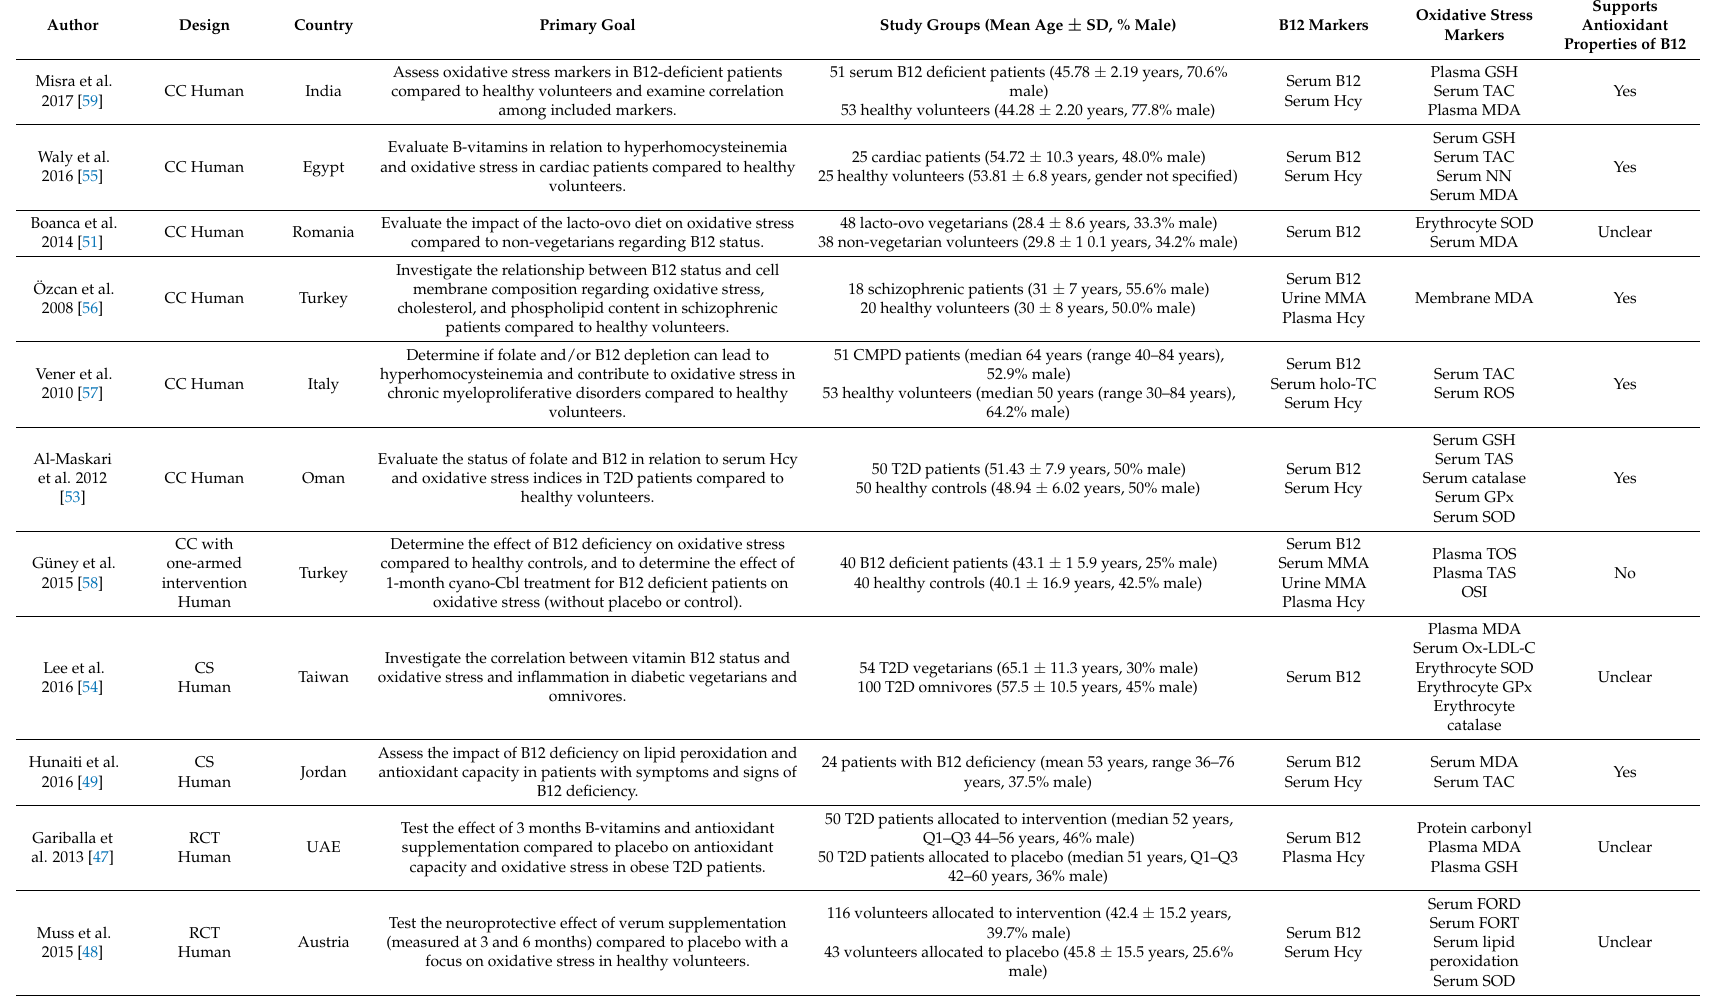
Table 1. Characteristics of included studies.